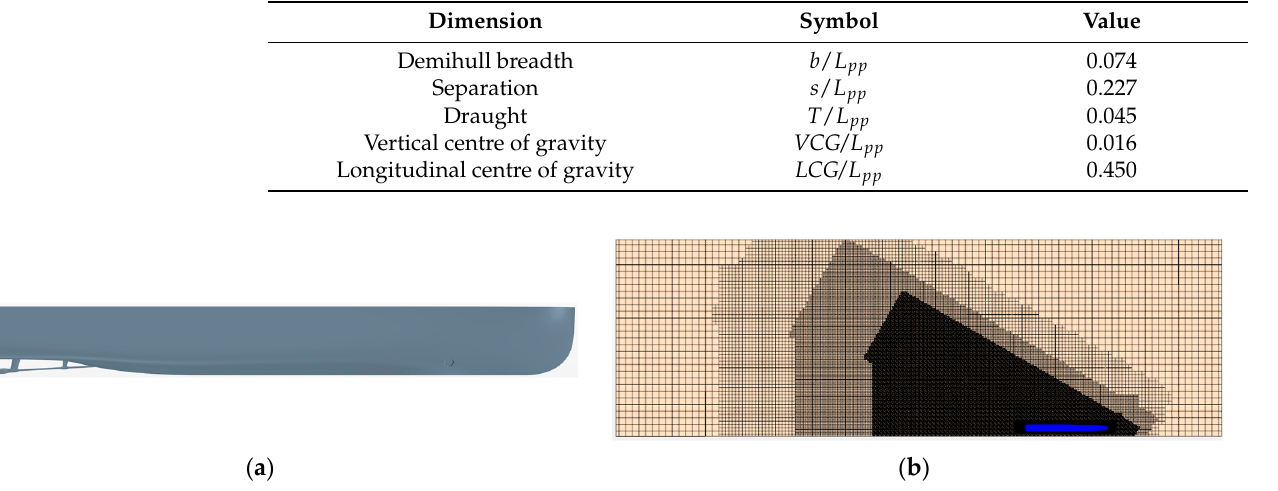
Figure 6. The geometry of the Stavanger demonstrator ( a ) and CFD mesh used for simulation ( b ). Table 3. Main dimensions of the Stavanger Demonstrator catamaran. Table 4. Total resistance coefficient of Stavanger demonstrator obtained from model tests and CFD